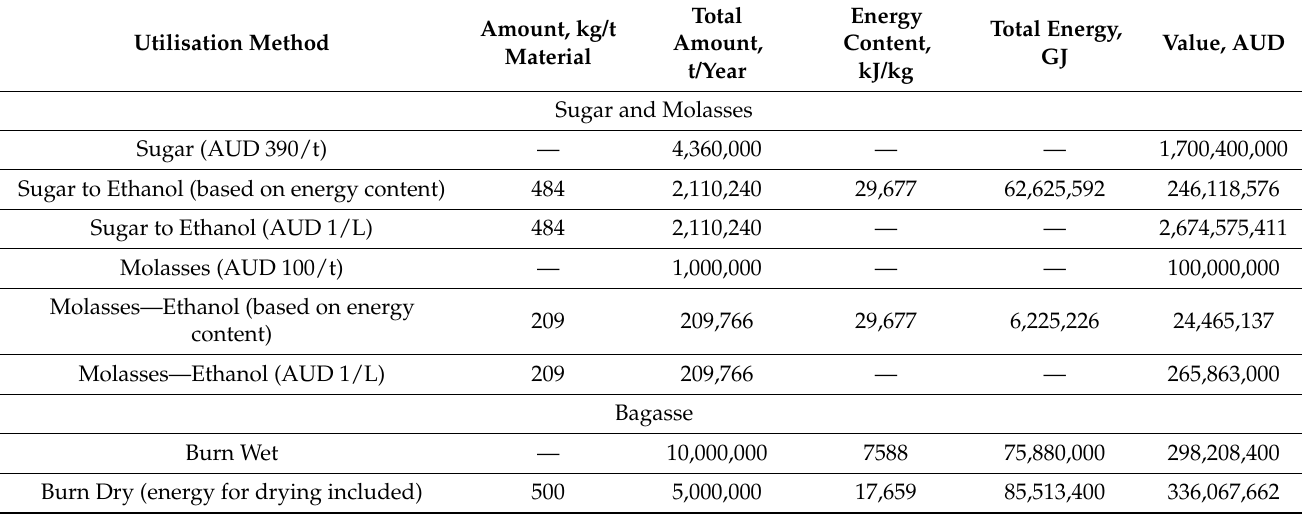
Table A1. Value proposition for different scenarios of utilising the wastes from sugarcane milling industry.